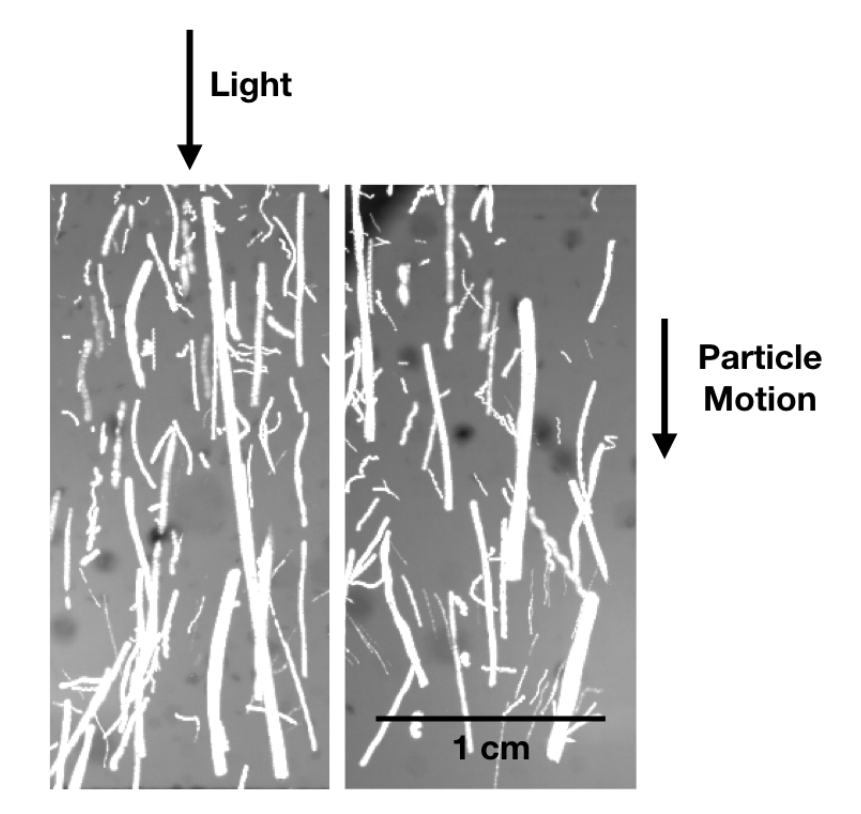
Figure 8. Photophoresis on JSC Mars 1a grains in a drop tower experiment. Two images with superpositions of 200 frames each from a movie sequence (duration = 0.4 s). The illumination is from the top with a laser beam with 20 kW/m 2 . The particle velocities depend on the size (smaller grains are generally slower) which is visible in the different track lengths. Larger grains still speed up though, as the gas–grain coupling time is in the order of the elapsed experiment time (see Kuepper et al. [113] for details of the